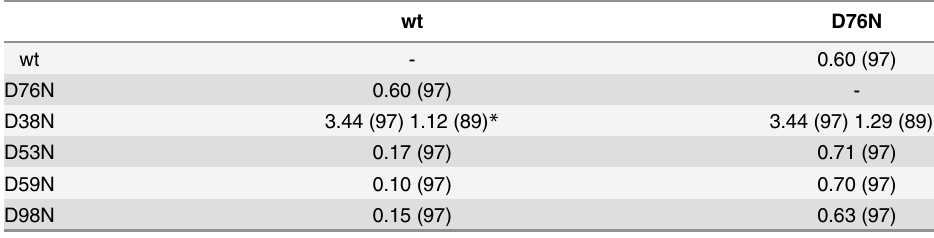
Table 3. RMSD values ( Å ) for the 3D structural comparisons of the D-to-N mutants with wt and D76N β 2m (pdb code 2YXF and 4FXL, respectively). The number of C α atoms used for each calculation is reported in